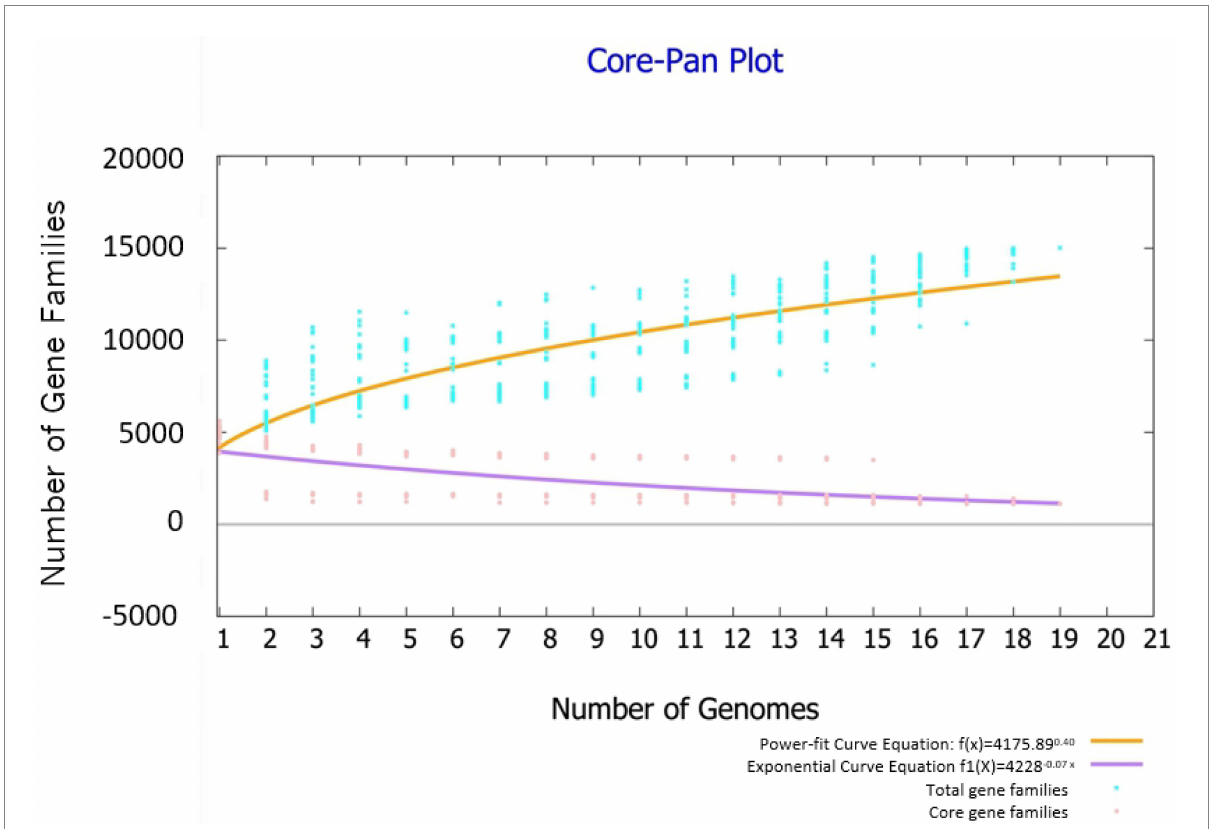
FIGURE 4 Pan genome and core genome profile plot of 19 Bacillus strains. The analysis was performed through the Bacterial Pan Genome Analysis (BPGA) software